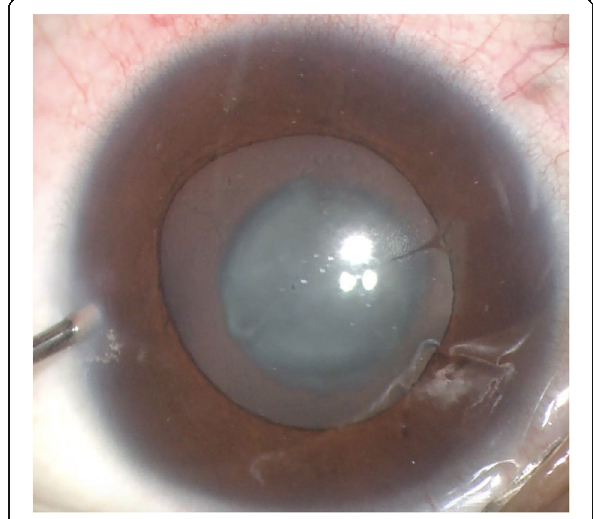
Fig. 2 Ocular photograph of the proband (II-1). The image was captured from the surgery video, which revealed the opacity of nuclear